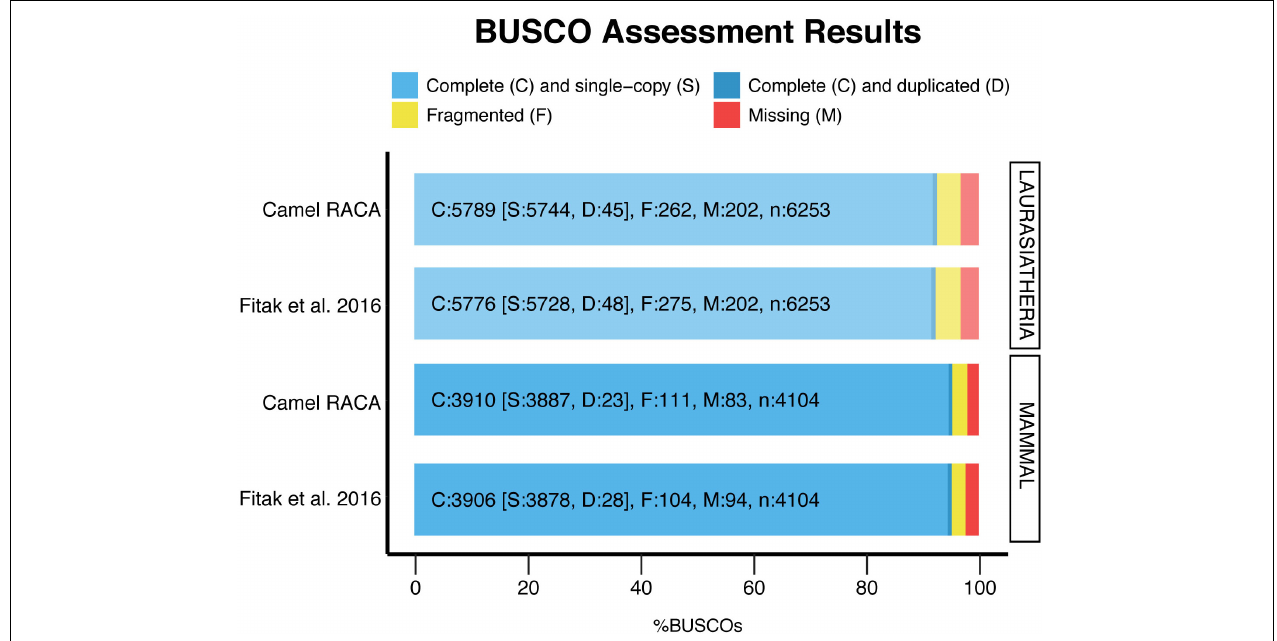
FIGURE 4 | Genome assembly evaluation. The BUSCO dataset of the mammalia odb9 including 4,104 BUSCOs, and the laurariatheria odb9, with 6,253 BUSCOs, were used to assess the new assembly (camel RACA) and the original scaffold-based assembly (Fitak et al., 2016).